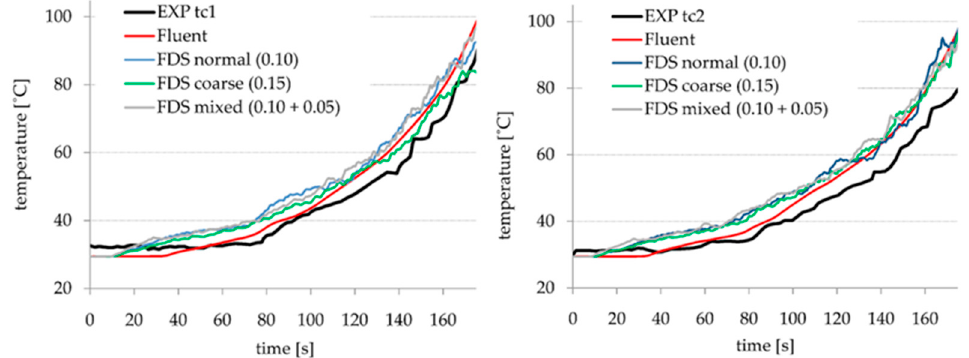
Figure 6. Time dependence of calculated and measured temperature for different FDS meshes for experiment #10. experiment #10.